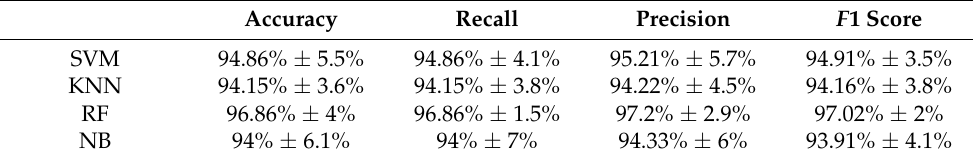
Table 2. Performance evaluation of the proposed method, including accuracy, recall, precision, and F1 measures (mean ± standard